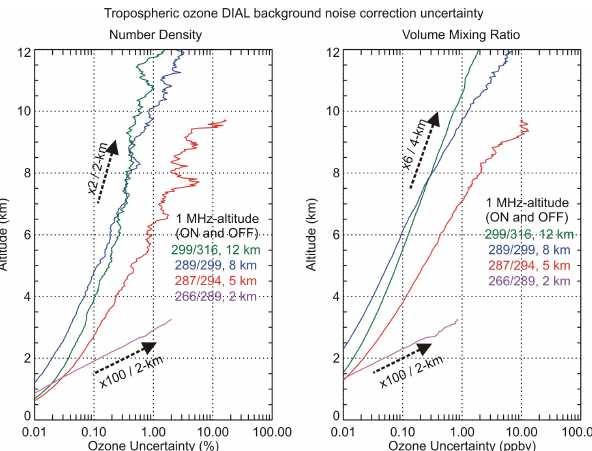
Figure 6. Same as Fig. 5, but for typical tropospheric ozone chan-